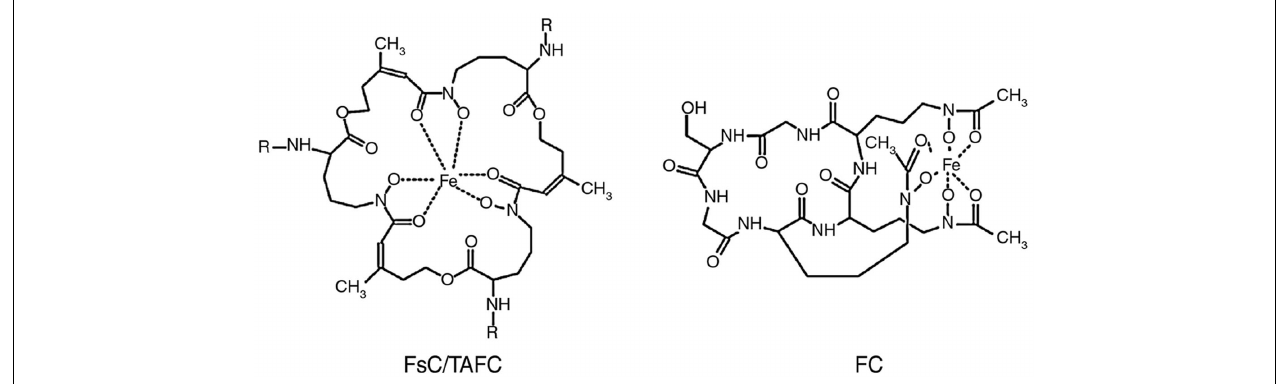
FIGURE 1 | Siderophores produced by A. fumigatus and A. nidulans : R = H in fusarinine C (FsC) and R = acetyl in triacetylfusarinine C (TAFC); the hydroxylation site in hydroxyferricrocin (HFC) is unknown. The siderophores are shown in the ferric (Fe 3 + ) form.